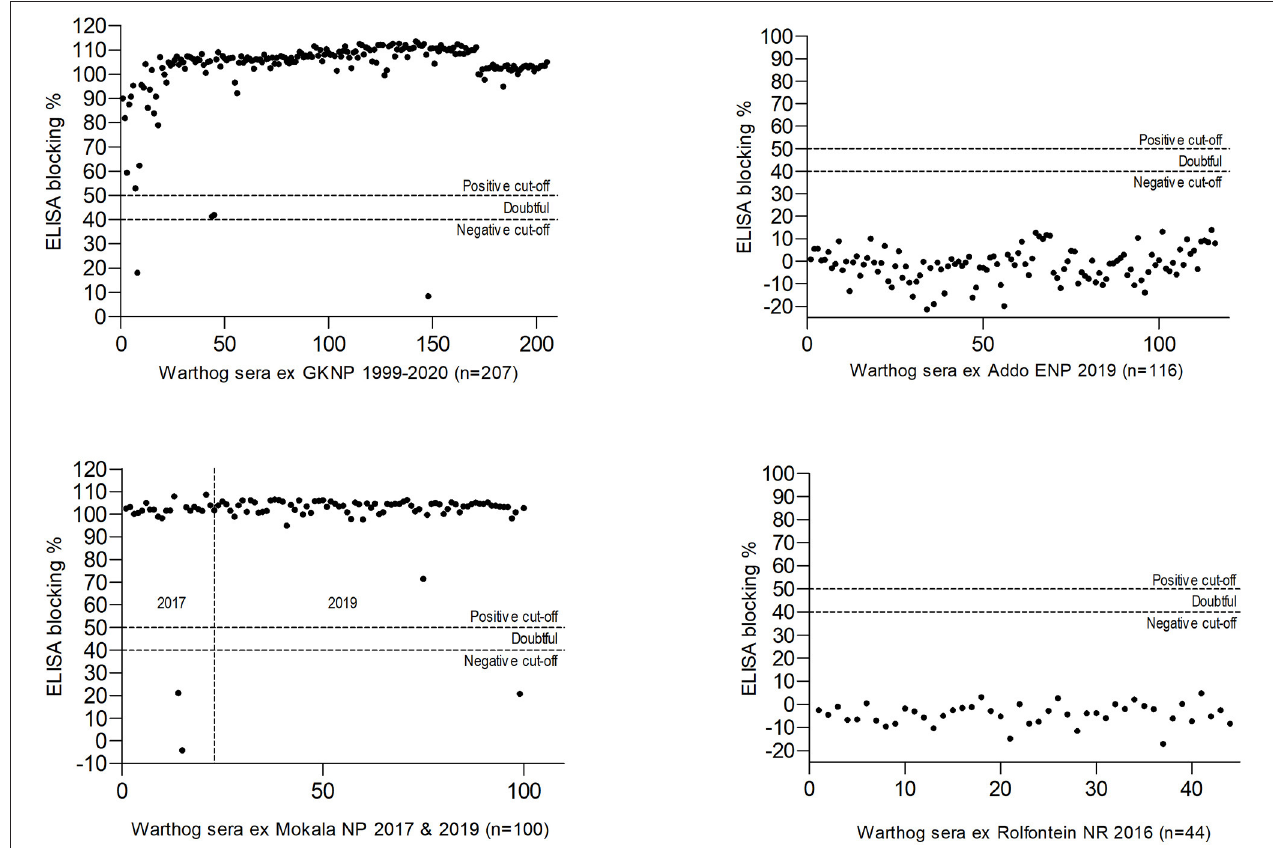
FIGURE 5 | Results of blocking enzyme-linked immunosorbent assays (ELISA) for antibody to African swine fever virus performed on warthog sera obtained from four nature reserves in South Africa (abbreviations as given in the text).